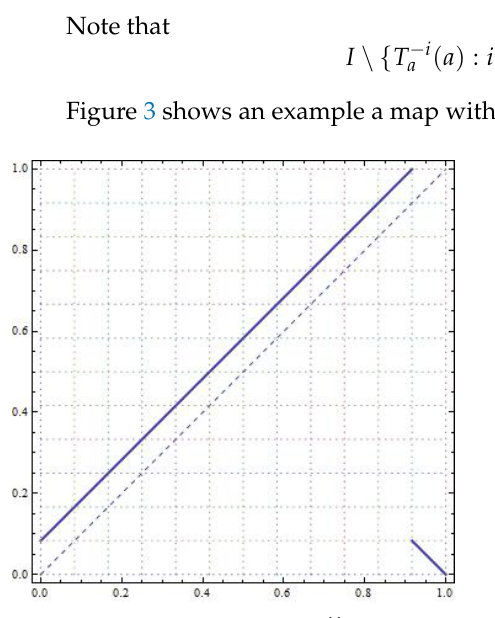
Figure 3. Graph of T a with a = 11 j = 1, . . .